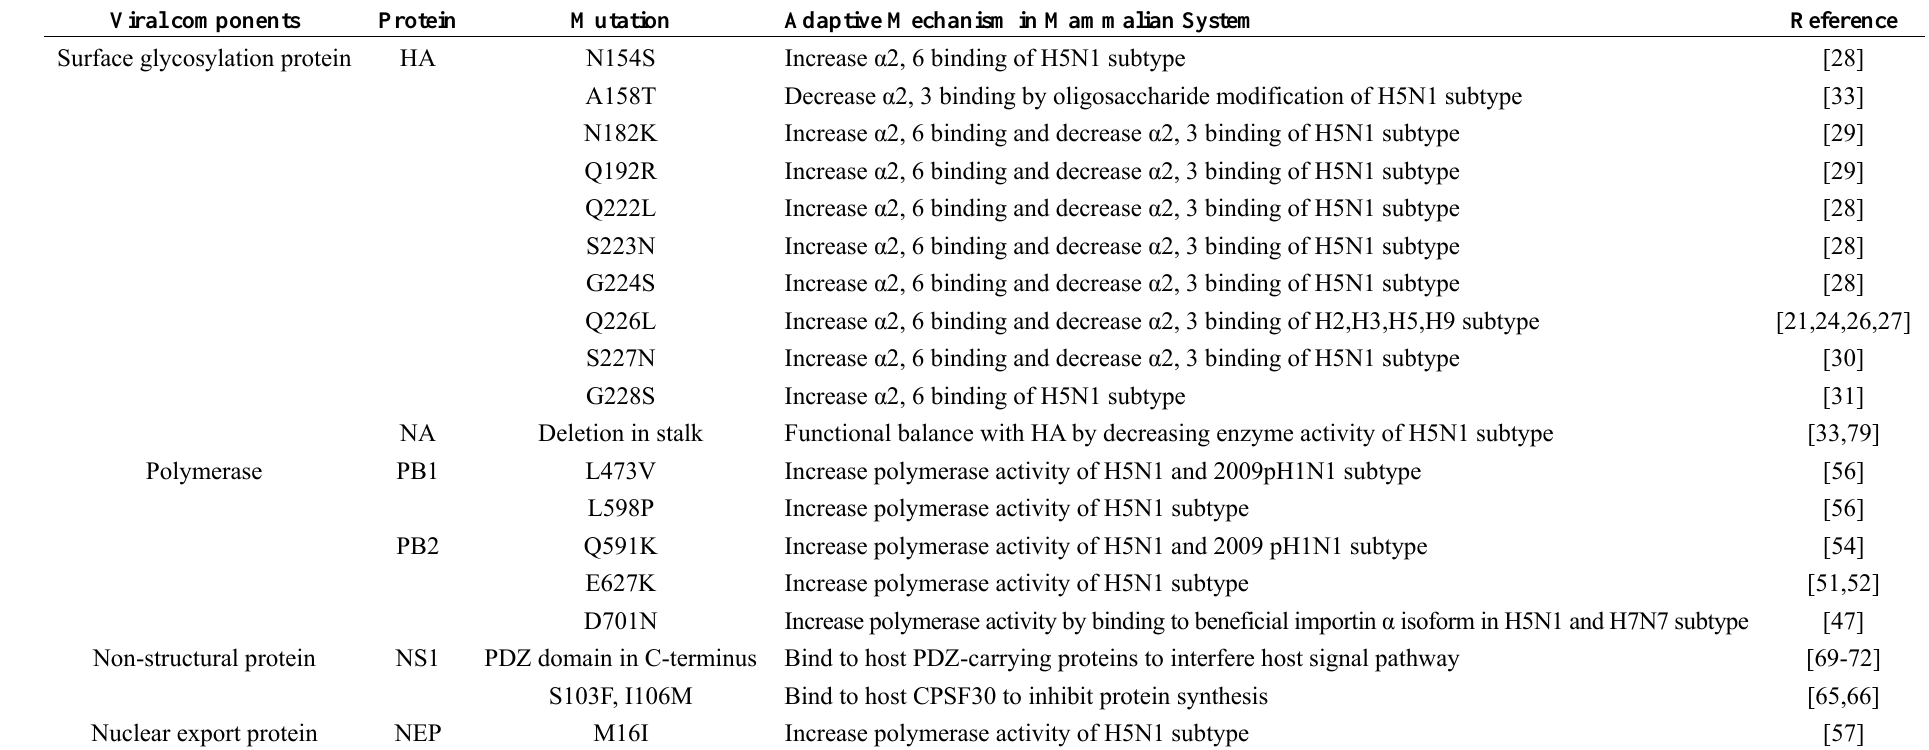
Table 1. Amino acid mutations involved in mammalian infection with H5N1